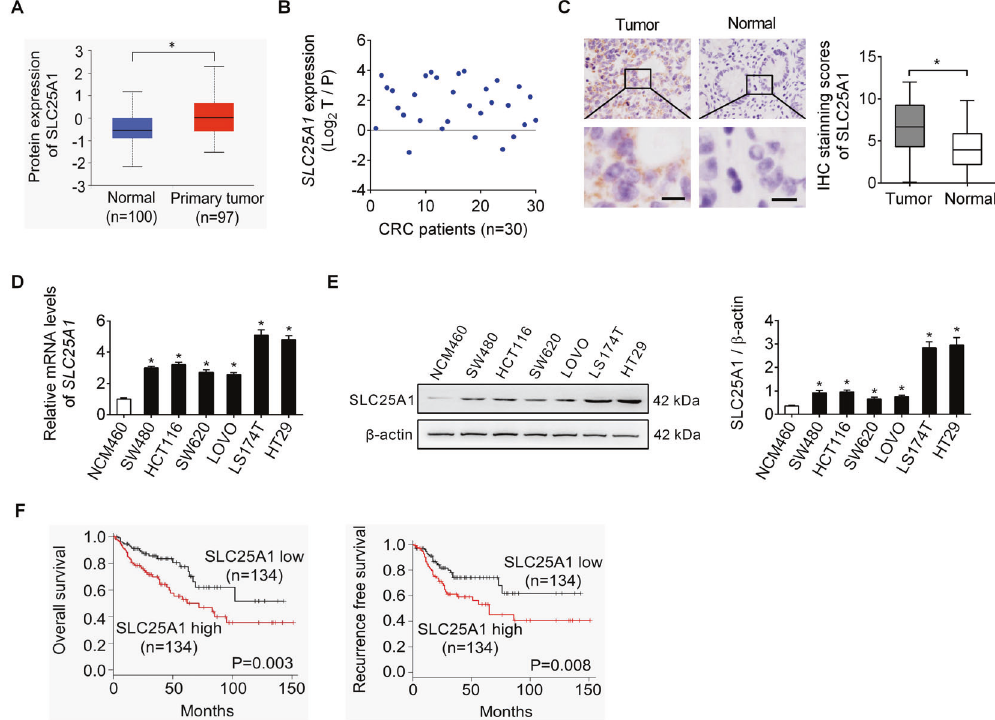
Fig. 1 SLC25A1 expression is markedly elevated in CRC. A Bioinformatics analysis from UALCAN database was applied for protein expression of SLC25A1 in tumor and normal tissues of liver. B qRT-PCR analysis for mRNA expression of SLC25A1 in tumor and matched adjacent nontumor tissues from 30 CRC patients. C Immunohistochemistry (IHC) staining of SLC25A1 in tumor and matched non-tumor tissues from another 268 CRC cohort. Scale bars, 10 μ m. D , E qRT-PCR and western blot analysis for SLC25A1 expression in human CRC cell lines and non-transformed colon epithelial cell line. F Kaplan – Meier overall survival (left panel) and progression-free survival (right panel) analyses were applied according to SLC25A1 expression in CRC